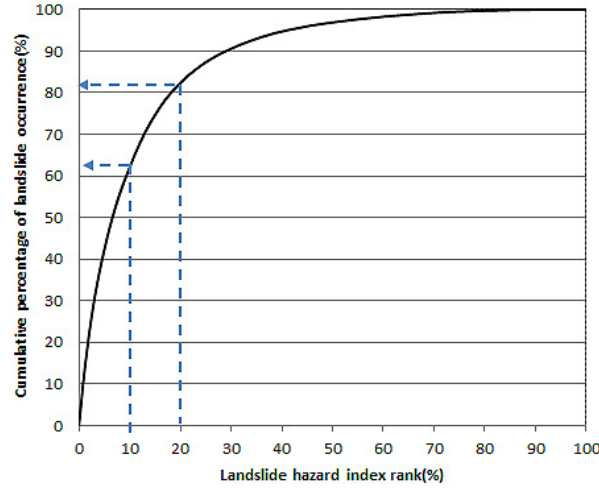
Fig. 13. Cumulative frequency diagram showing cumulative landslide hazard index rank occurring in cumulative percentage of landslide